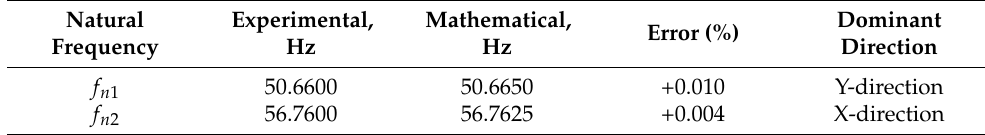
Table 2. Experimental and mathematical natural frequencies of studied